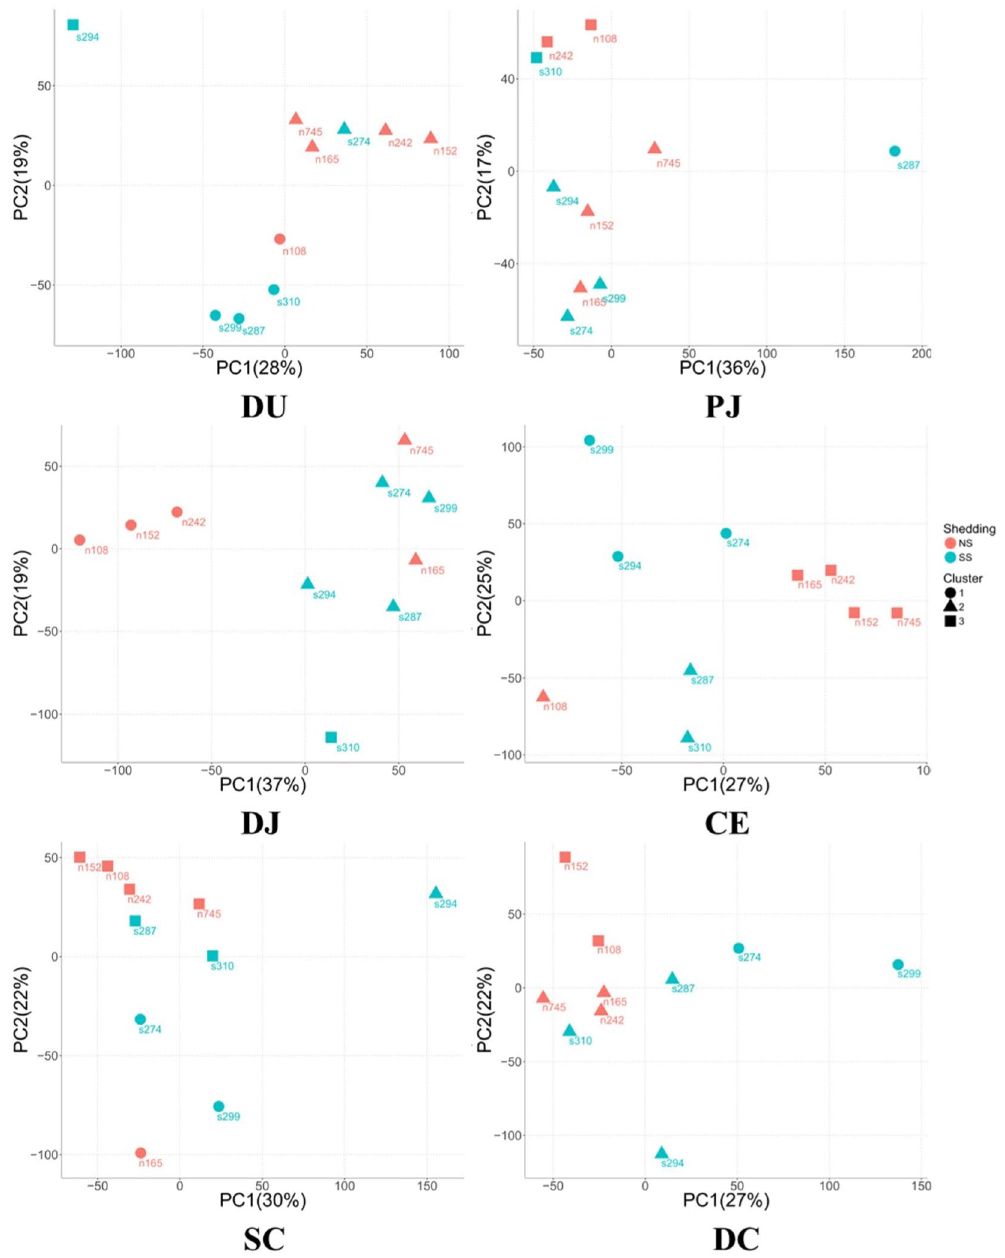
Figure 2. Principle component analysis for core transcriptome of all tissues. The red circles indicate non- shedders that are clustered together based on their gene expression profiles. The expression values of each gene were scaled by subtracting mean expression value then dividing by standard deviation. The cluster analysis was performed using k-mean algorithm. DU, duodenum; PJ, proximal jejunum; DJ, distal jejunum; CE, cecum; SC, spiral colon; DC, descending